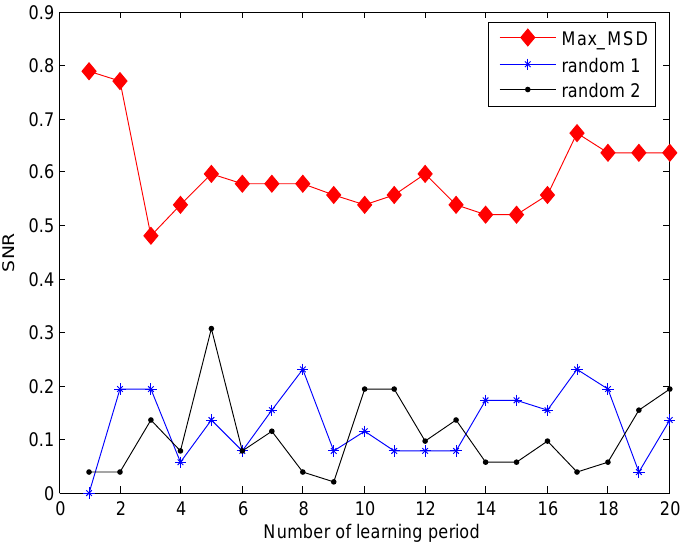
Figure 5. Effect of active nodes selection using the Max − MSD and random approaches on